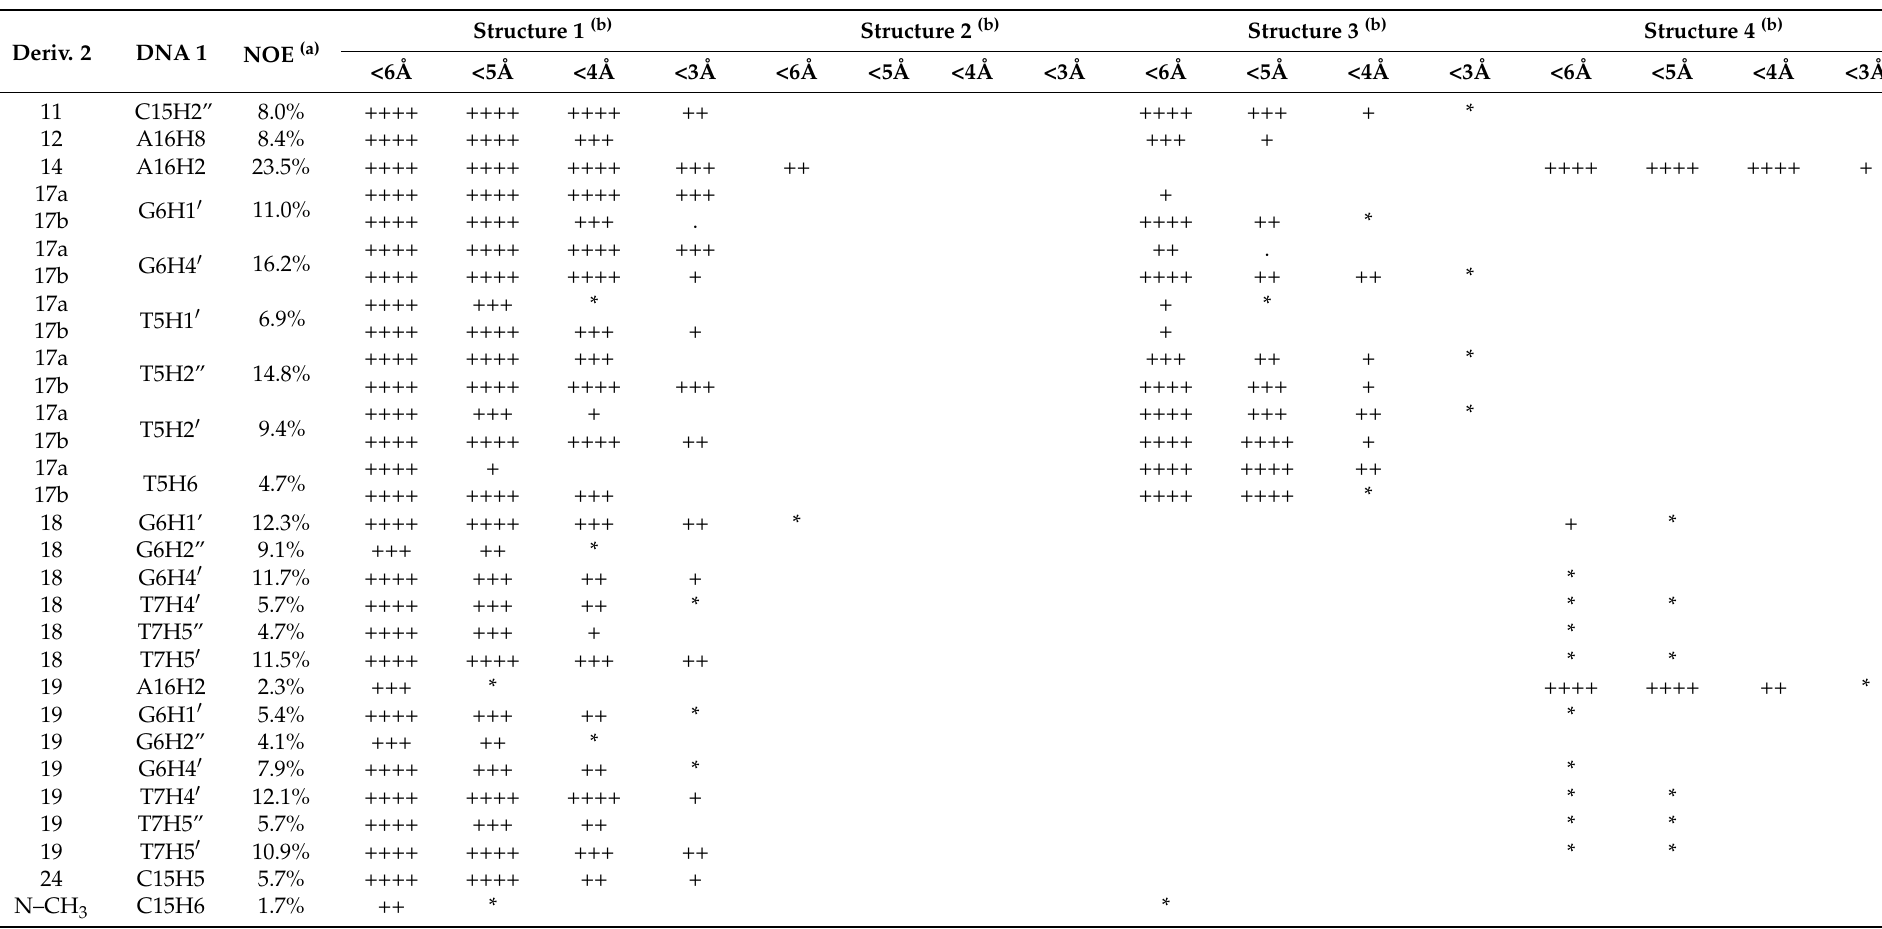
Table 4. The analysis of measured distance statistics for selected protons in conformers recorded during MD trajectories for four possible structures with observed intermolecular NOE effects. Deriv.